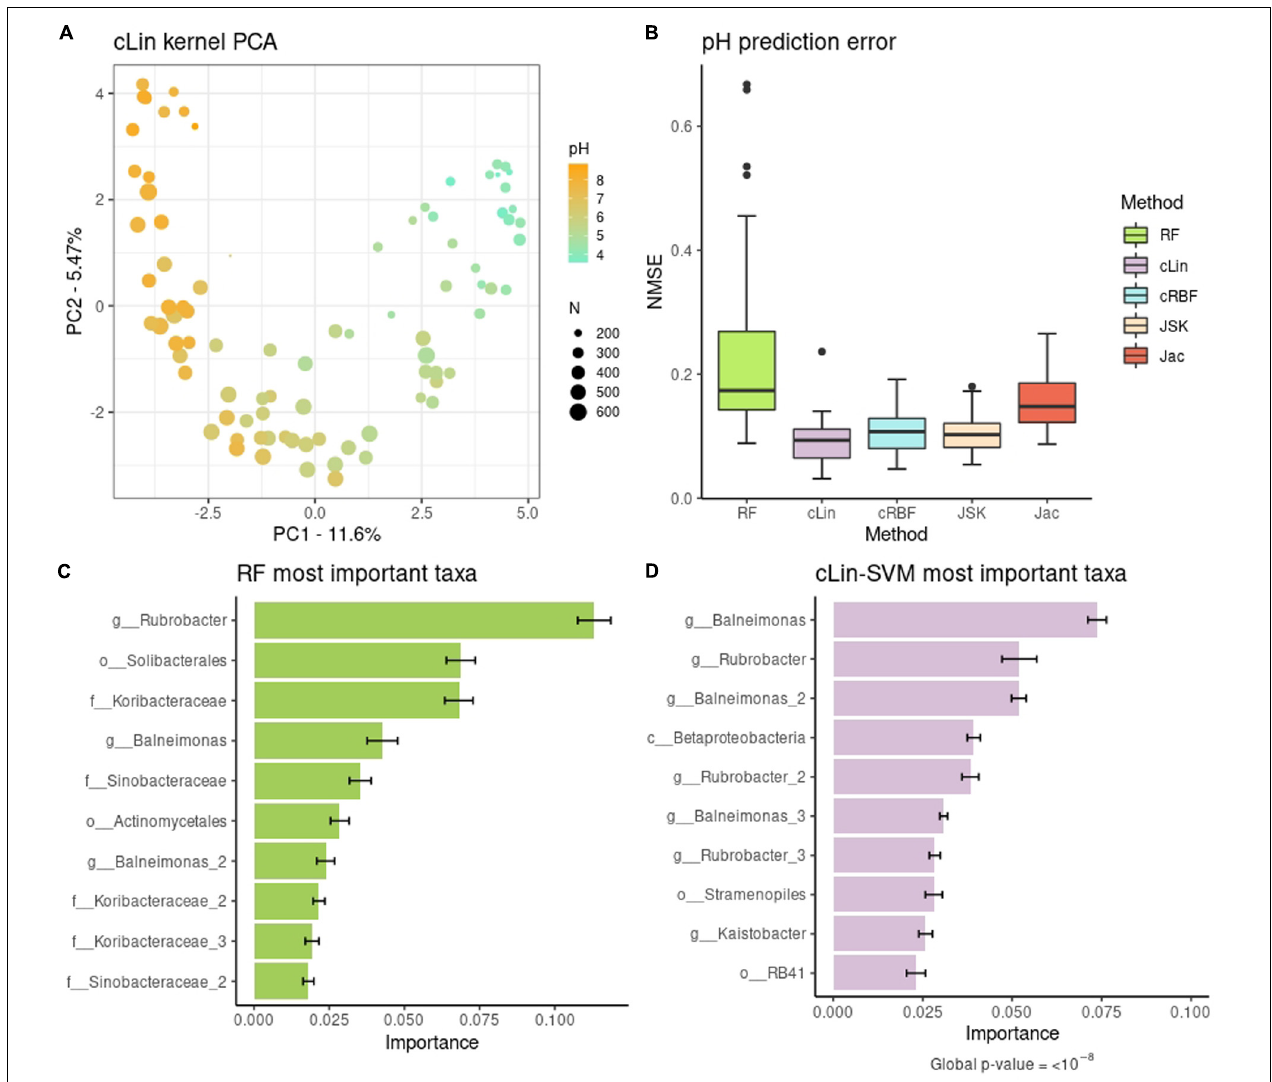
FIGURE 2 | (A) Compositional linear kPCA over the 88 soils. Color represents pH, while point size stands for the number of different observed taxa. (B) pH prediction error distribution over the 40 replicates. (C,D) Top relevant taxa for pH prediction according to RF and cLin-SVM. Standard error across the 40 replicates is marked with error